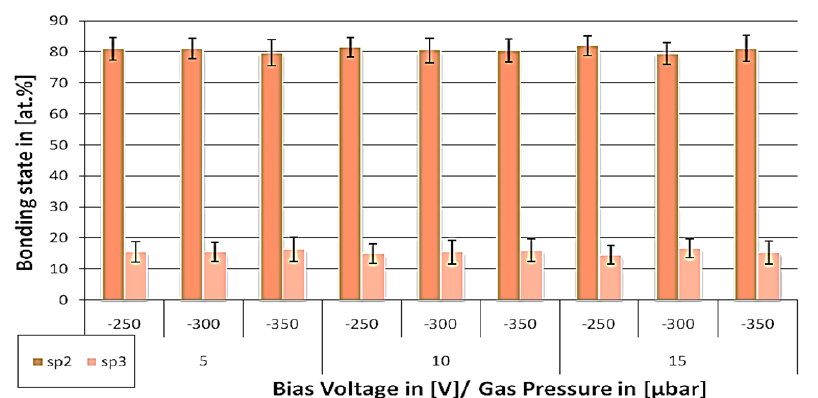
Figure 2. Chemical bonding states (sp 2 /sp 3 content) for samples DLC-Si-316L-01 to